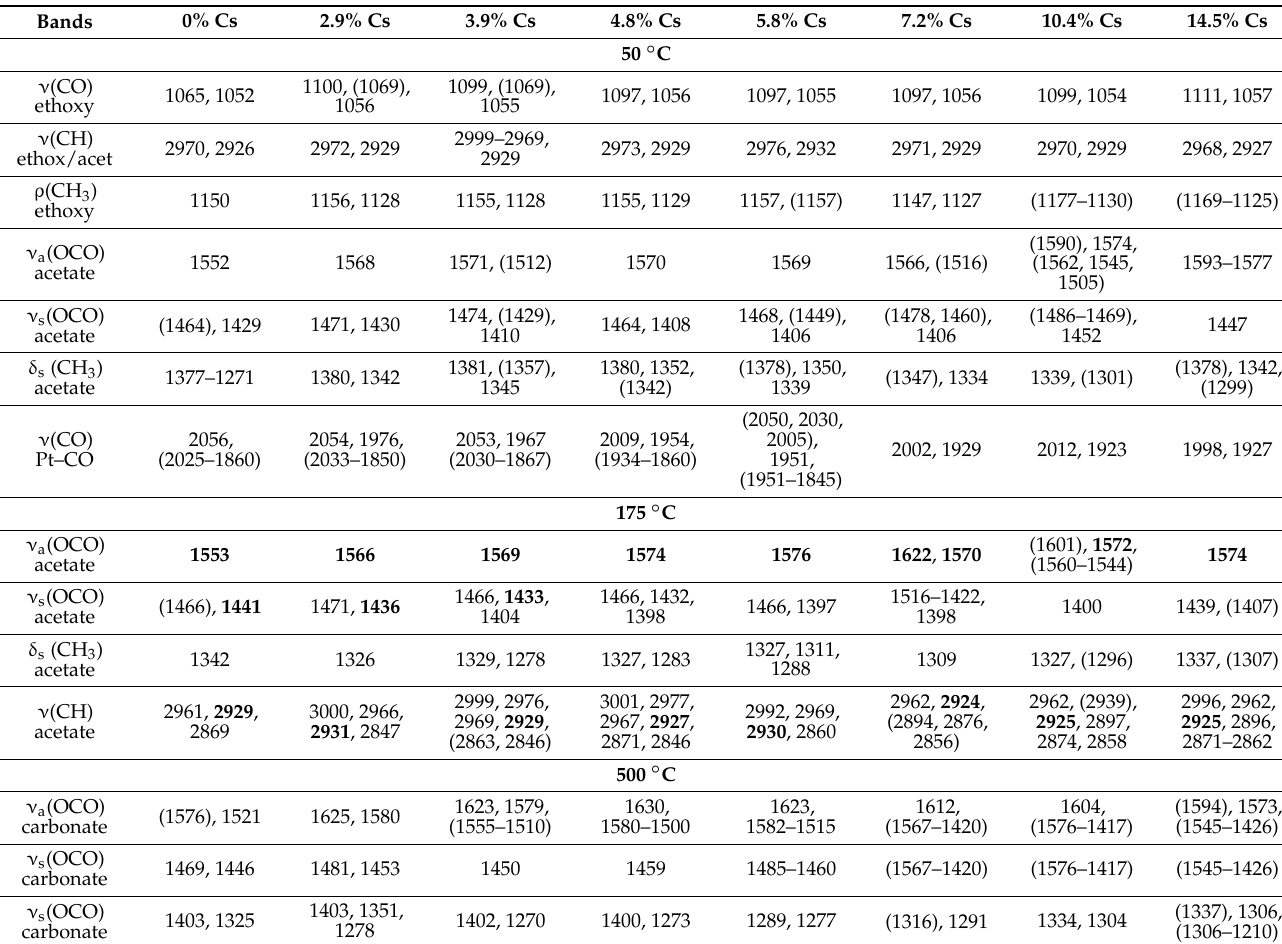
Table 3. Main bands in cm − 1 observed for unpromoted and Cs-promoted 2% Pt/m-ZrO 2